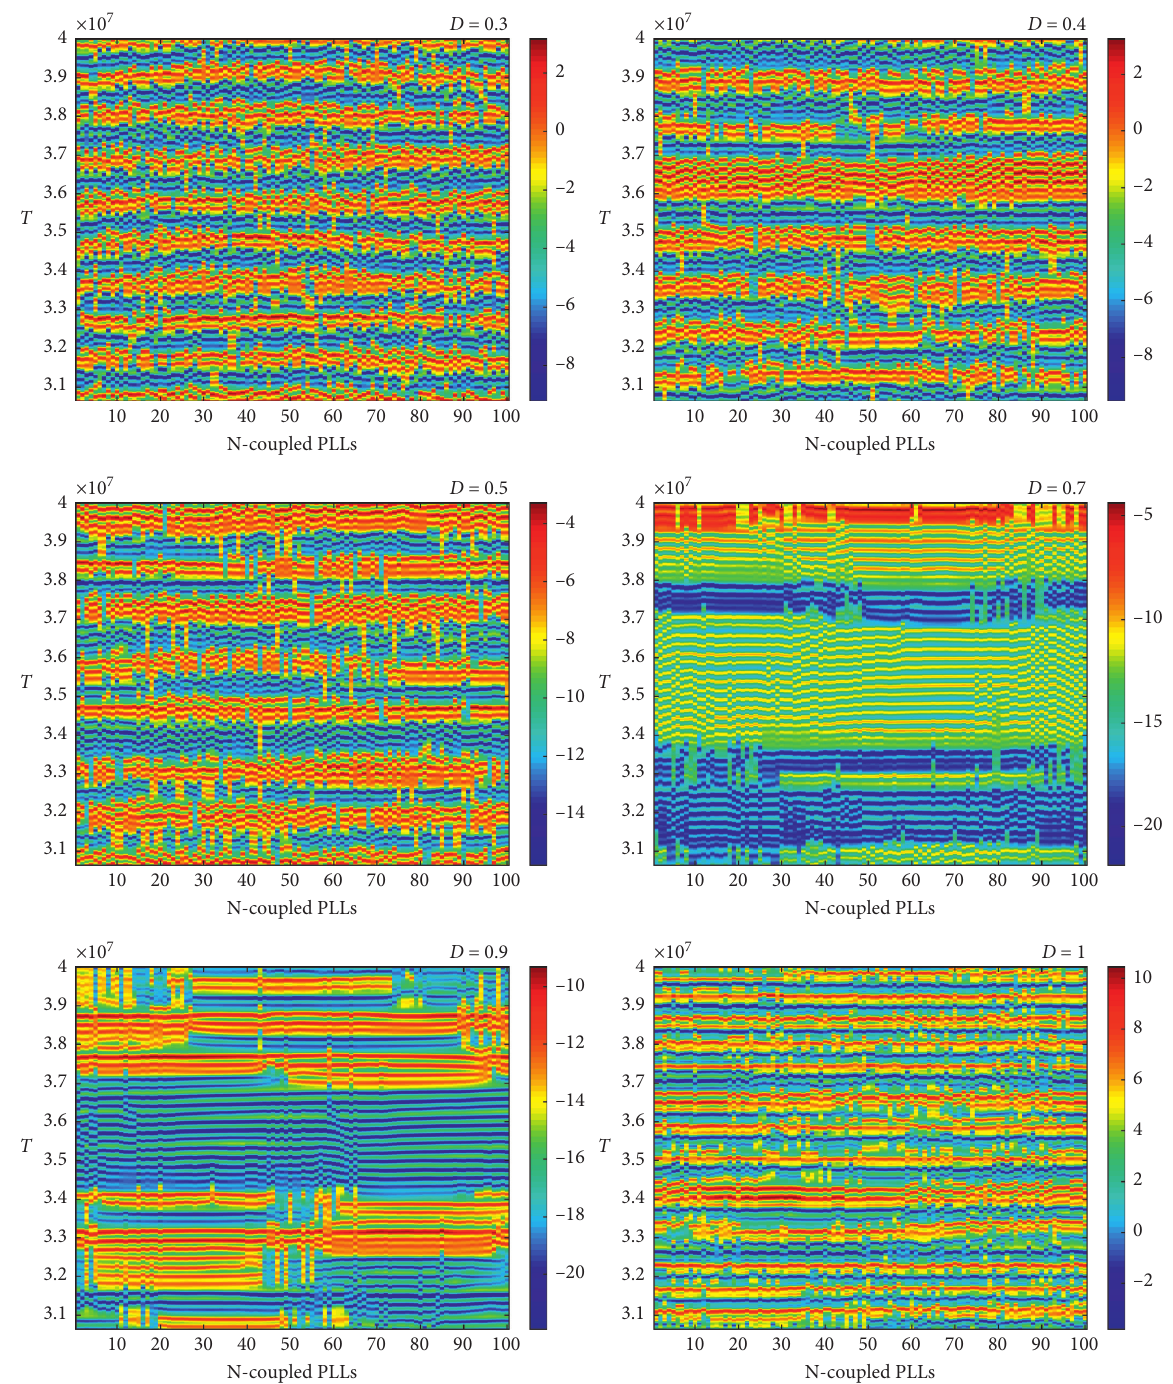
Figure 6: Spatiotemporal dynamics of the FOPLL network showing chimera-like behaviour for the coupling strength 0 . 3 ≤ D ≤ 1. We have used random initial conditions between the range [ − π , π ] for all the FOPLLs. The fractional order is fixed at q � 0 . 98 and the system parameters are fixed at K � 2 . 6 ,G �